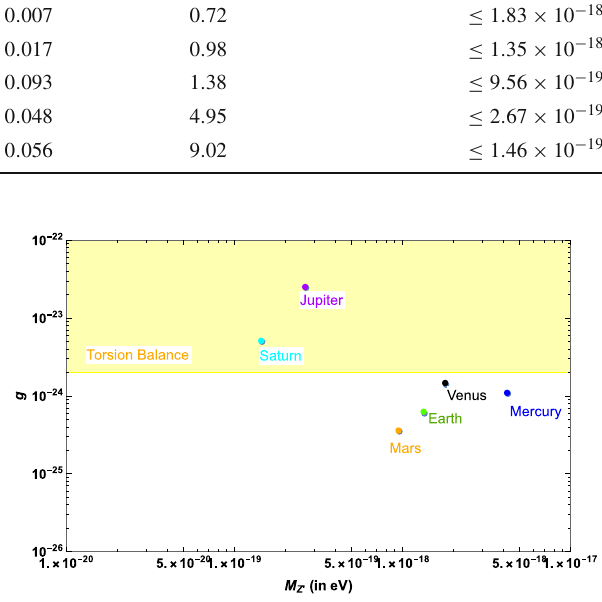
Table 1 Summary of the masses, eccentricities [37] of the orbits, perihelion distances from the Sun and upper bounds on gauge boson mass M Z (cid:2) which are mediated between the planets and Sun in our Solar System